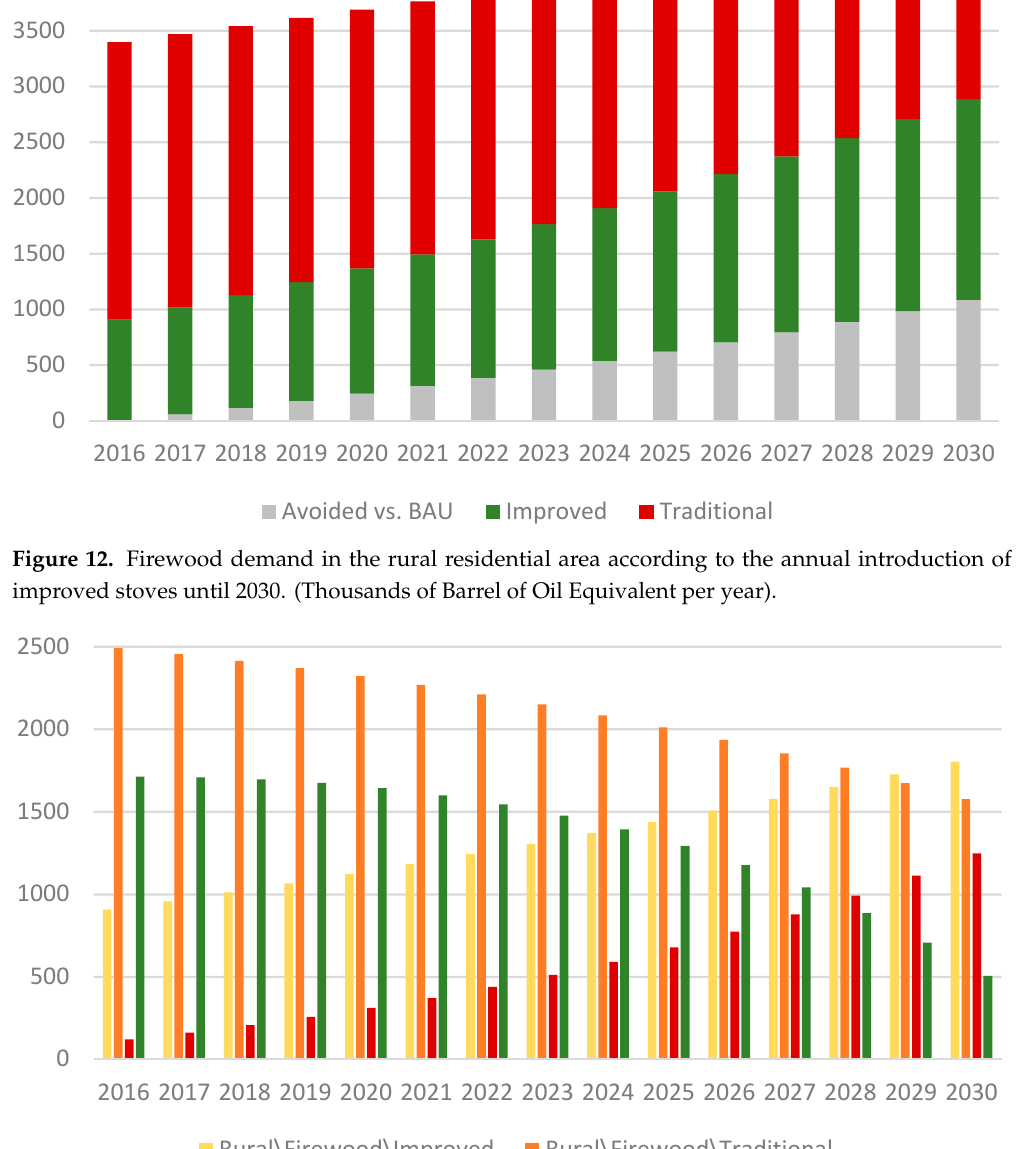
Figure 13. Energy demand in both urban and rural residential areas according to the annual introduction of improved stoves until 2030. (Thousands of Barrel of Oil Equivalent per year)